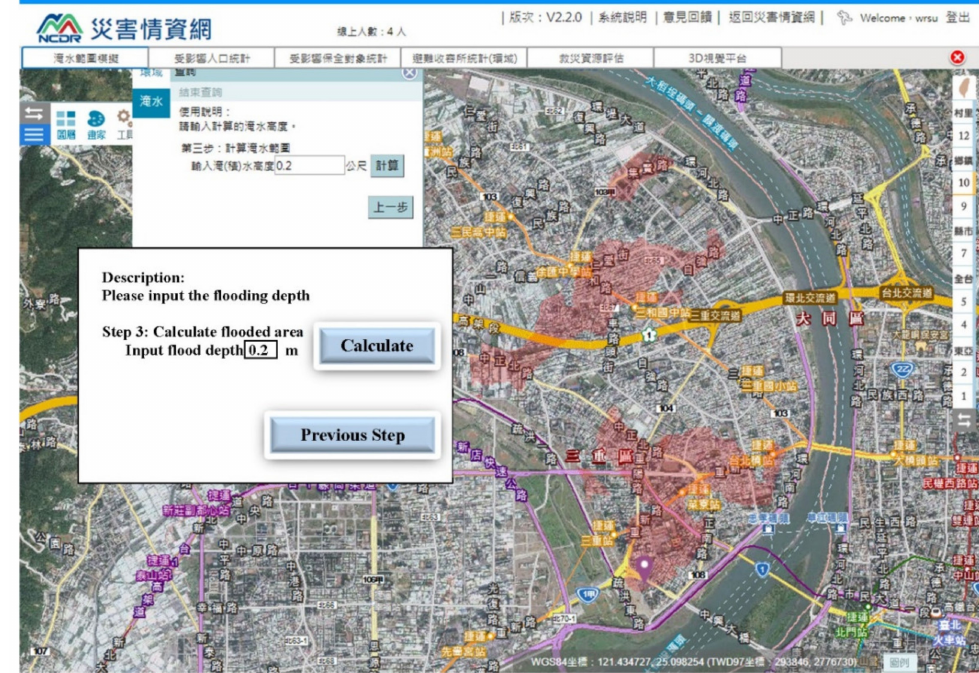
Figure 4. Method 1: Using the center point and flooding depth to calculate flooded areas.